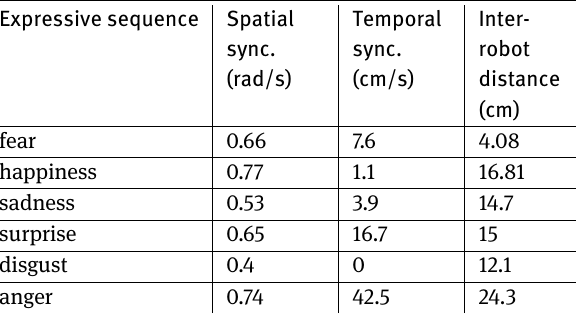
Table 5: Control attributes computed for each sequence. Small standard deviation of the rotational velocity shows high spatial synchronicity, small difference in maximum velocities show high temporal synchronicity and small standard deviation of the average distance to the swarm centroid shows small inter-robot distance.